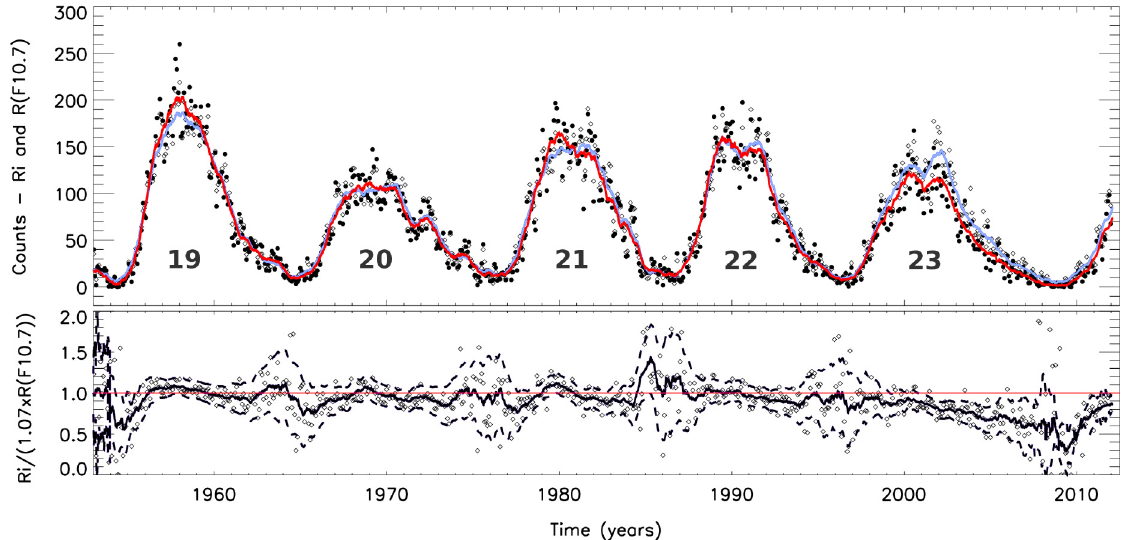
Fig. 1. Comparison of R i and the F 10.7 proxy for R i over the last 60 years (Johnson 2010). Top panel: plots of the monthly R i and F 10.7 values (black and white dots respectively) and of the 1-year smoothed R i and F10:7 values (red and blue curves respectively). The cycle numbers are indicated. Bottom panel: monthly ratios R i /F 10.7 (diamonds) and the 1-year smoothed ratio (solid line) with the 3 r confidence levels (dashed lines). It shows the overall agreement between the indices until the year 2000 and the significant discrepancy appearing after